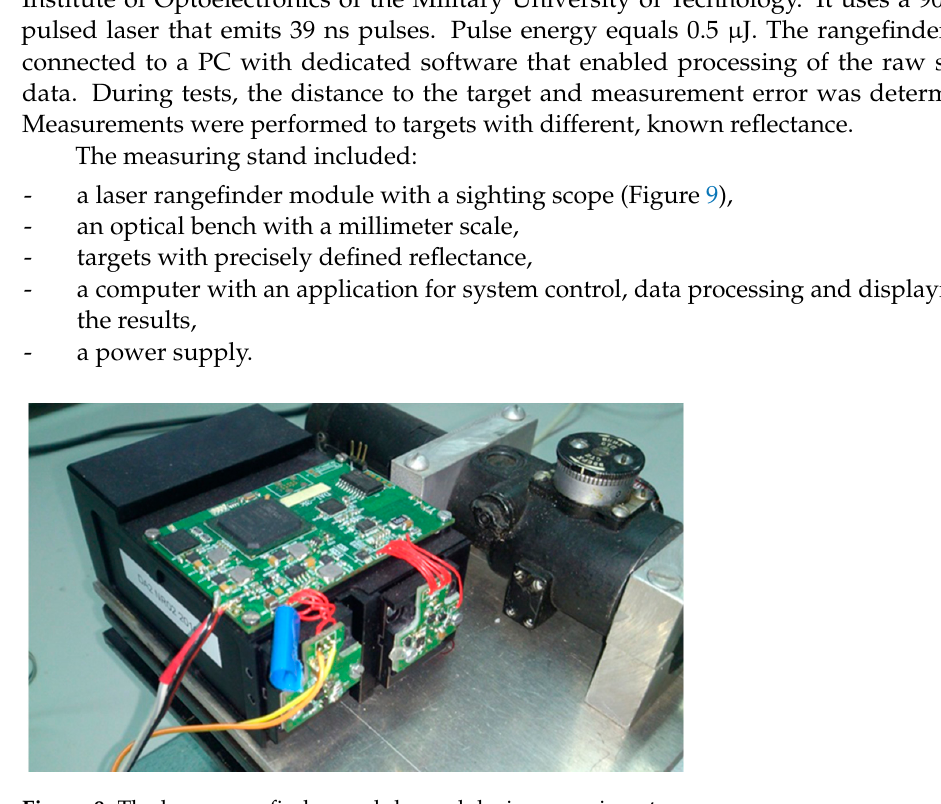
Figure 10. The schematic diagram of the test stand. In order to examine the influence of the changes in the signal to noise ratio (SNR) on the error of distance measurements, it was assumed that the variable parameter (influenc- ing the peak value of received signals) will be the reflectance of targets. Used targets and their corresponding reflectance for the wavelength λ = 905nm are shown in Figure 11. Figure 11. Test targets with calibrated reflectance used in the experiments. Reflectance equals ( A ) 98%, ( B ) 47%, ( C ) 10%, ( D ) 1%.